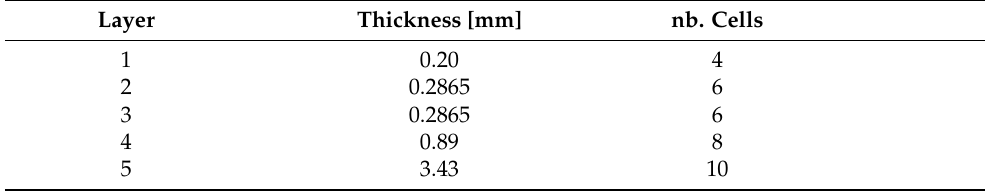
Figure A10. Comparison between results obtained with 2 meshes (10,000 cells and 20,000 cells) during the last 3 cycles. Table A3. Thickness and discretization of the multilayered stack.